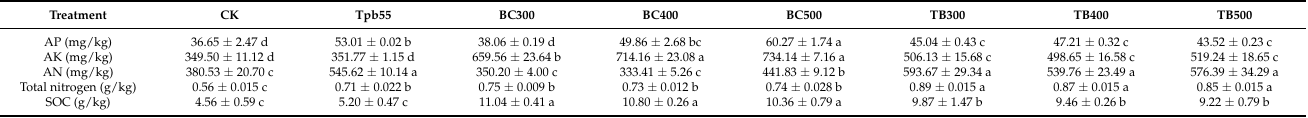
Table 3. Effects of different treatments on the available nutrients of